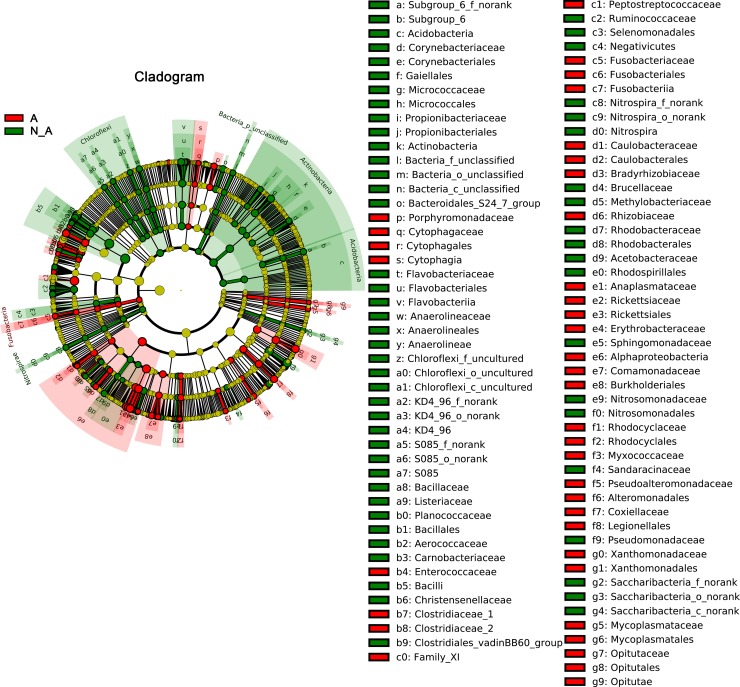
Differentially abundant bacterial taxa in the spleen microbiota between Anaplasma-positive and Anaplasma-negative samples identified by LEfSe analysis.Cladogram showed the highly represented taxa in Anaplasma-positive and Anaplasma-negative samples, respectively. A: Anaplasma-positive, in red; N_A: Anaplasma-negative, in green.